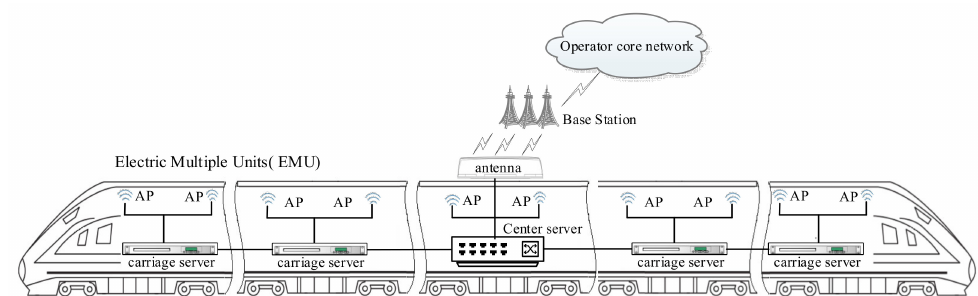
Figure 3. The wireless local area network of EMU.